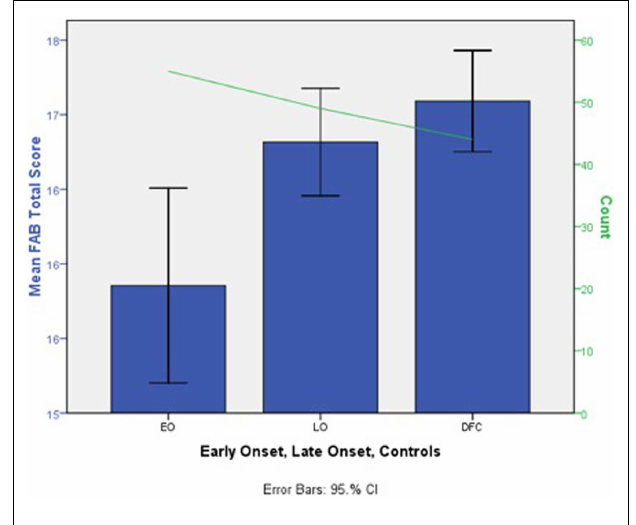
FIGURE 4 | Deficits in mean total FrontalAssessment Battery (FAB) total score in early adolescent MJ use onset (EO, n = 49), late adult onset (LO, n = 55), and control groups (DFC, n = 44) (scores are in a T -score metric; mean = 50, SD = 10 with lower scores indicating impairment; adapted from Fontes et al., 2011)